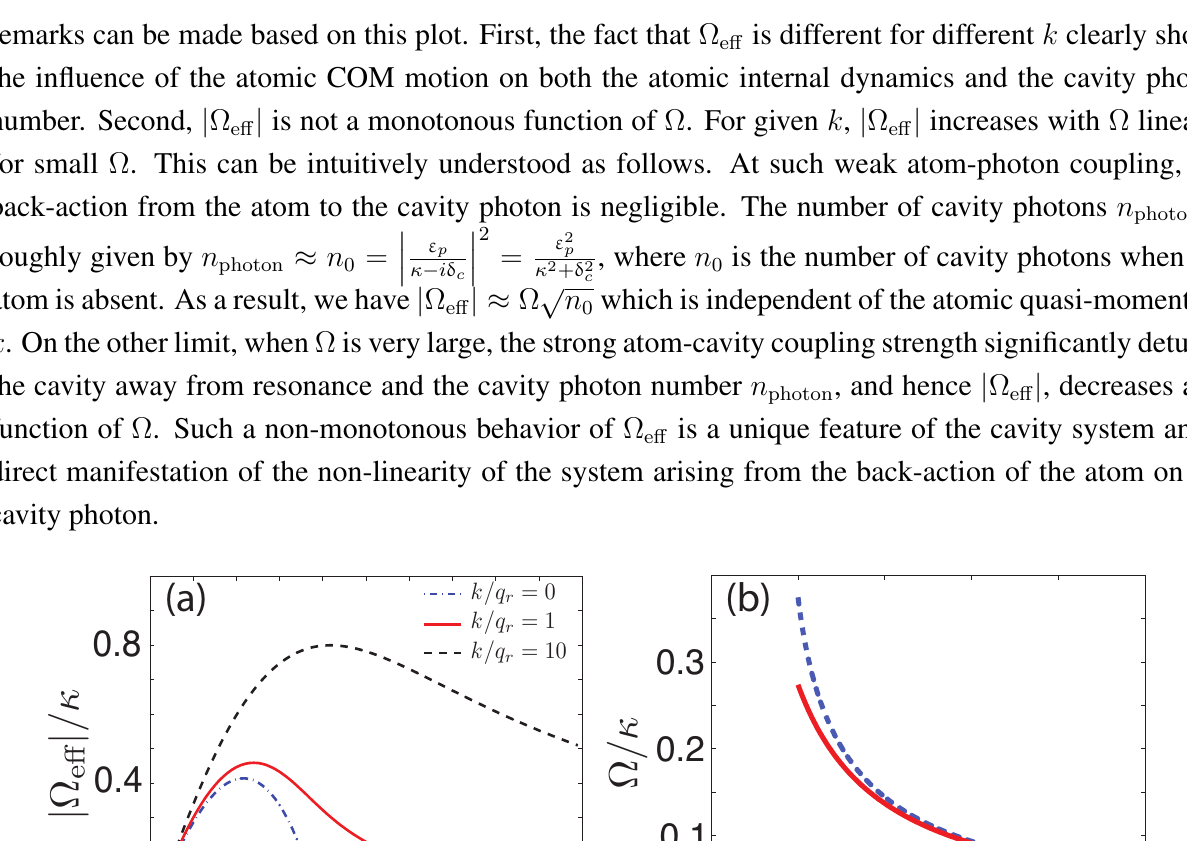
Figure 3. ( a ) Effective Raman coupling coupling strength Ω for different k values, 0 , q dashed lines. We observe that peaks at an intermediate value, then approaches zero in the large Ω limit. Figure ( b ) shows a comparison between critical boundary of region I and II (red solid curve) and the analytical result (blue dashed line) given in Equation (6). At large ε asymptotically